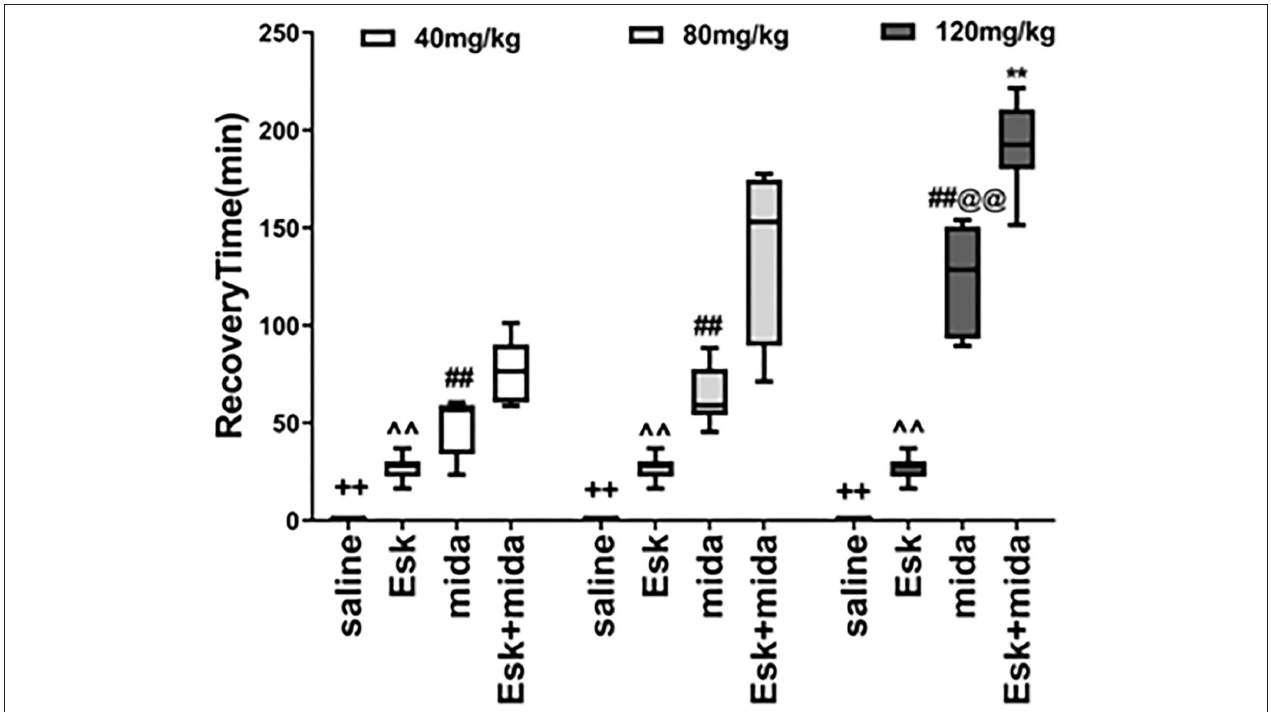
FIGURE 4 | Recovery Time. ++ P < 0.01, compared to Esk, Mida, and Mida + Esk groups. ∧∧ P < 0.01, compared to Mida, and Esk + Mida groups. ## P < 0.01, compared to Esk + Mida group. @@ P < 0.01, compared to Mida40 and Mida80 groups. ** P < 0.01, compared to Esk + Mida40 groups.